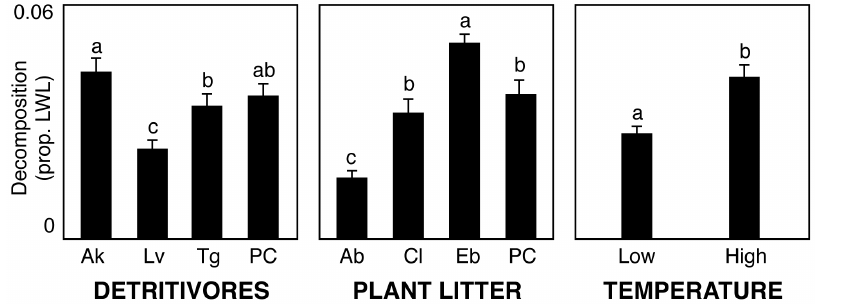
Figure 1. Decomposition rates. Mean 6 SE detritivore-mediated decomposition rates (measured as the proportion of leaf weight loss per capita) in each detritivore/plant litter assemblage and temperature treatment. Different letters within panels indicate significant differences (Tukey test, a =0.5). Ak, Anisocentropus kirramus ; Lv, Lectrides varians ; Tg, Triplectides gonetalus ; Ab, Apodytes brachystyllis ; Eb, Endiandra bessaphila ; Cl, Cryptocarya leucophylla ; PC,